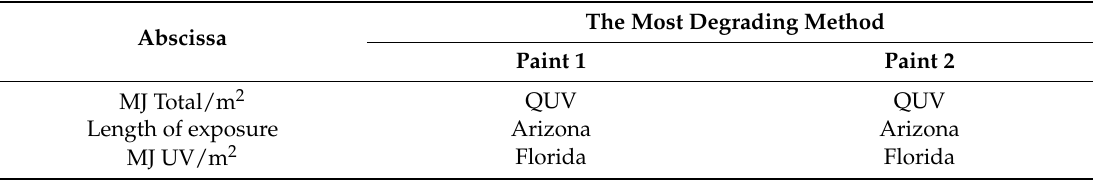
Table 6. The most degrading methods in terms of the abscissa